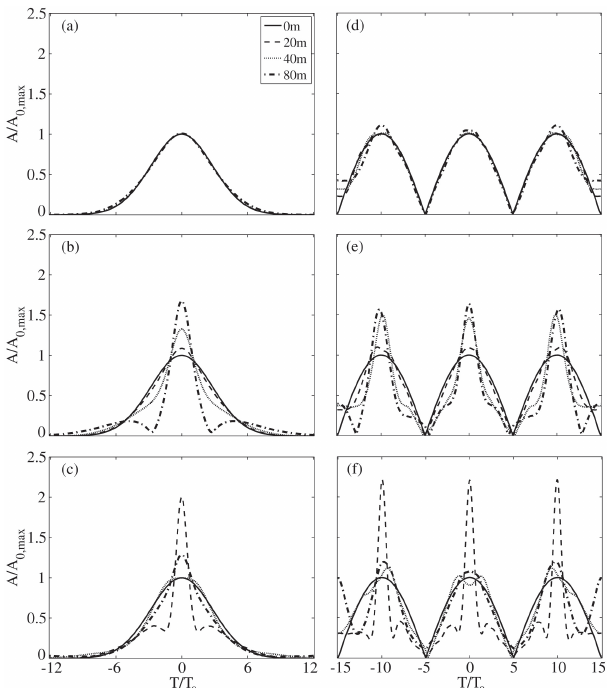
Fig. 3. Spatial variations of wave envelopes in three typical sea states. (a–c) are from Gaussian waves and (d–f) are from bichro- matic waves. The three rows of panels correspond to the smooth, moderate and severe sea states,